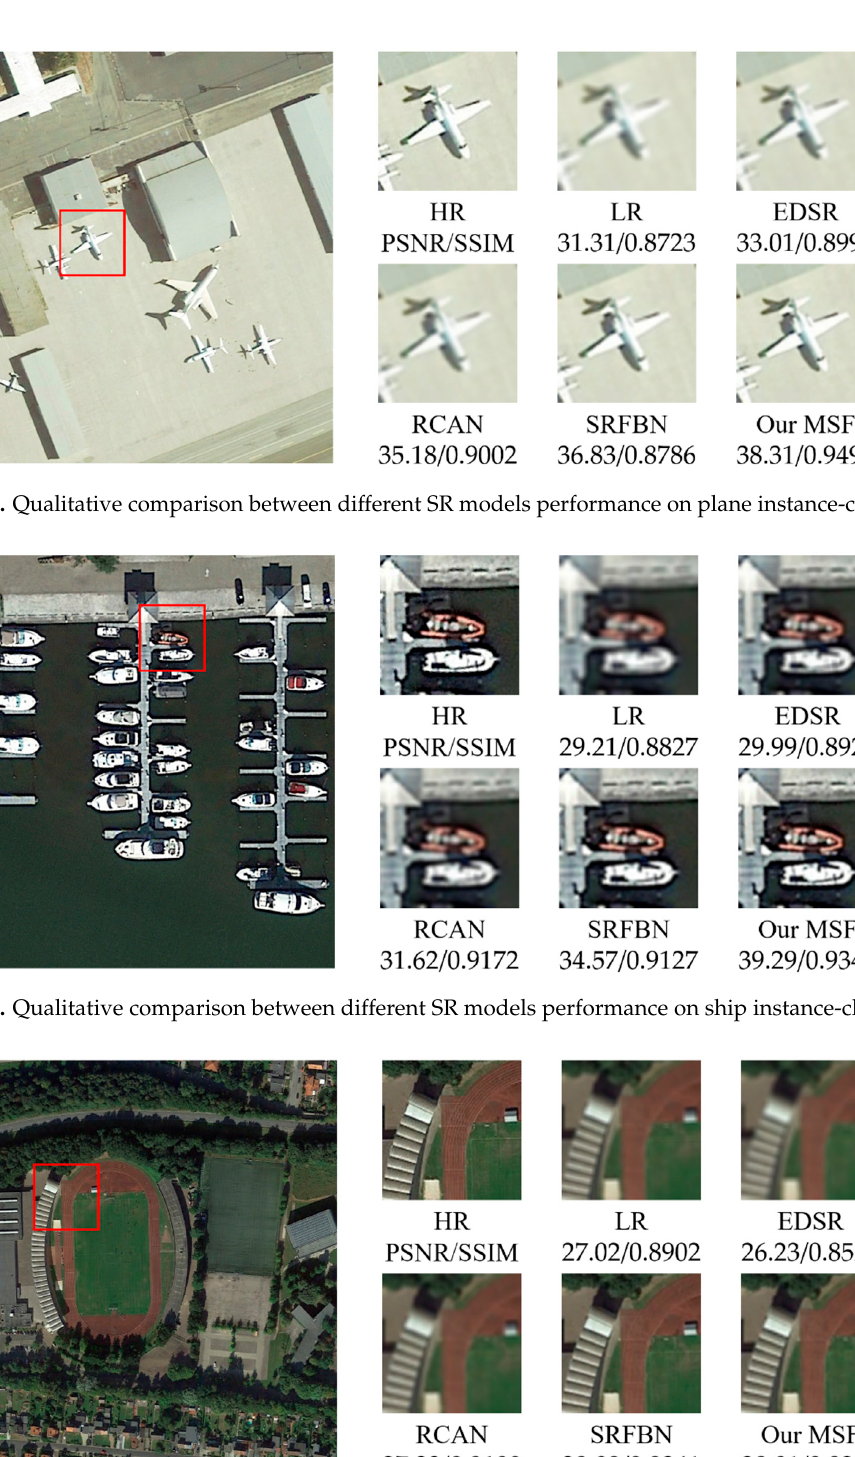
Figure 9. Qualitative comparison between different SR models performance on storage tank instance-class. 3.2.2. The Influence of Different Scaling Factors In this part, our purpose is to compare the performance of MSF and other SR algo- rithms on the data with different scaling factors. We adjust the scaling factor (2,3,4) in the bicubic downsampling step. Theoretically, with a larger scaling factor, the downsampled piece loses more texture information and details, making the framework more struggled